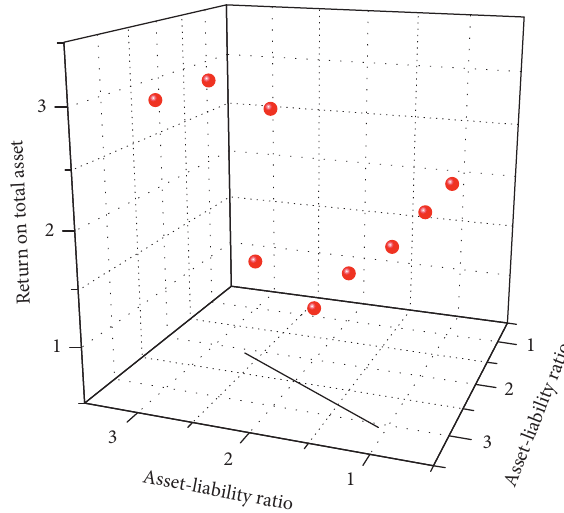
Figure 12: Rule extraction validation